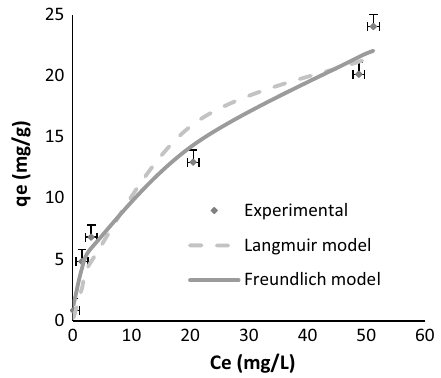
Fig. 6 Two-parameter isotherm models for adsorption of Cr(VI) onto LLAC under optimum conditions (adsorbent dosage = 0.57 g; pH 4.22; temperature = 26.2 °C; and contact time = 60 min)